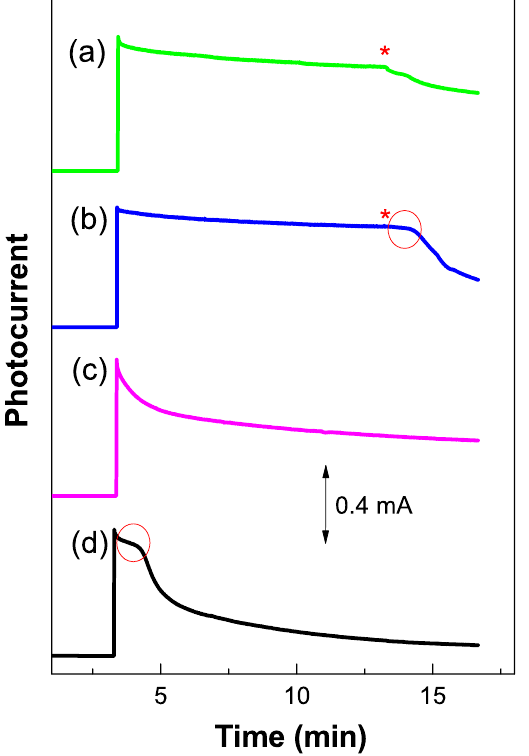
Figure 3. Photoelectrochemical response of the all-V continuous-flow PESC to different electrolyte flow conditions. Both the anode and cathode flow (at 0.2 ml/s) was on at the beginning of the tests, and light was turned on at 3 min. ( a ) At 13 min the anode flow was switched off (denoted by an asterisk). ( b ) At 13 min the cathode flow was switched off. ( c ) Anode flow was switched off at 3 min. ( d ) Cathode flow was switched off at 3 min.